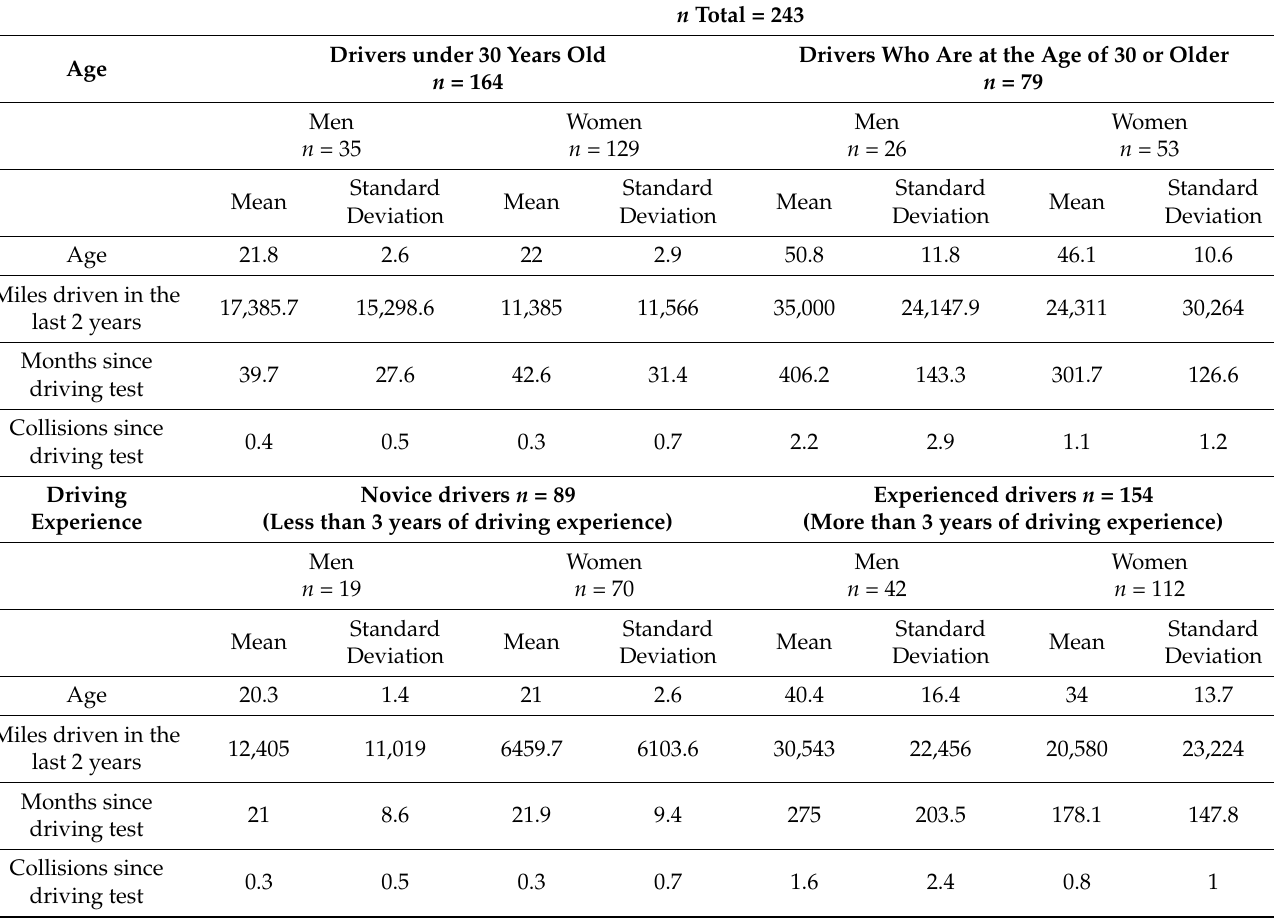
Table 1. Descriptive statistics for all participants across age, gender and driving experience. n Total =